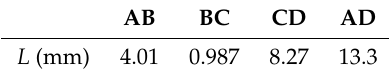
Table 2. Length, L , of the channel sections along which pressure drop measurements were